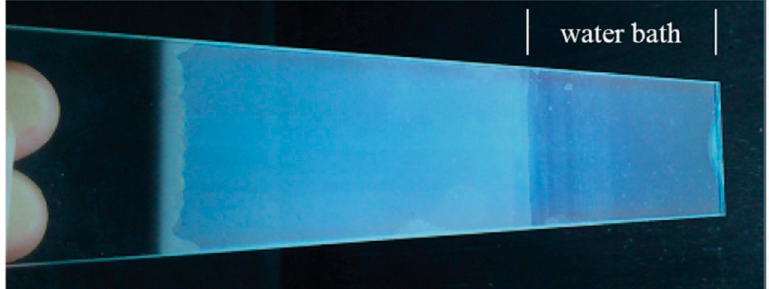
Figure 13. Layer 1 (from MgAlF 5 sol) after 14 days of water bath. Reproduced from Reference [48] with the permission of the Royal Chemical Society.